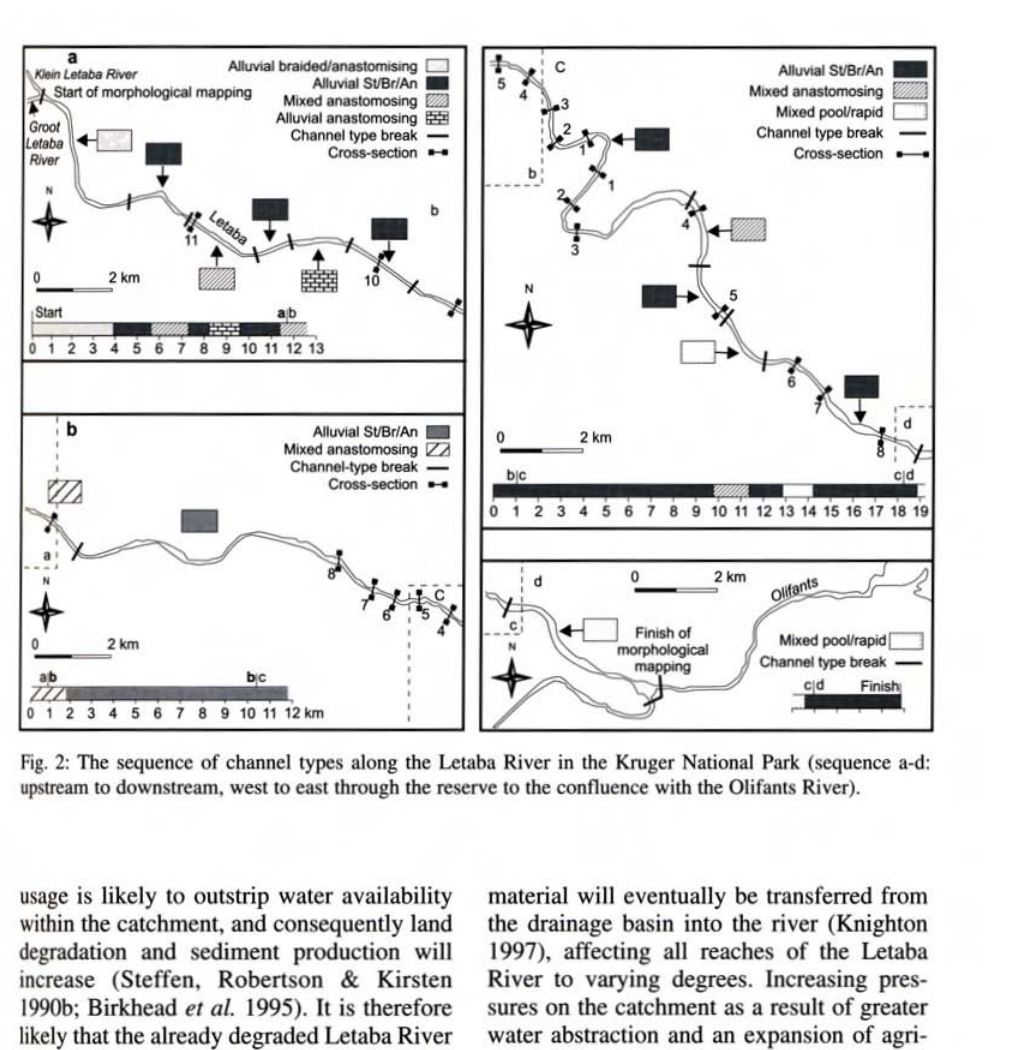
usage is likely to outstrip water availability within the catchment, and consequently land degradation and sediment production will increase (Steffen, Robertson & Kirsten 1990b; Birkhead et ai. 1995). It is therefore likely that the already degraded Letaba River will experience further reductions in water volume and an increase in sediment input. Geomorphological and ecological changes will occur as a result . and it is for Ihis rea son that the nature of geomorphological change needs to be understood. Sediment production in the Letaba catch ment has been estimated from land use, soil